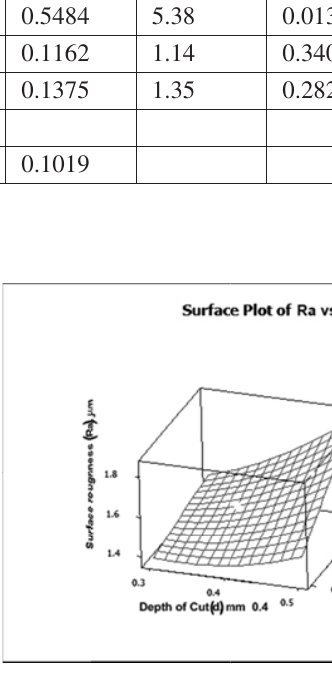
Figure 4. 3D Surface plot of R a vs. f and d .